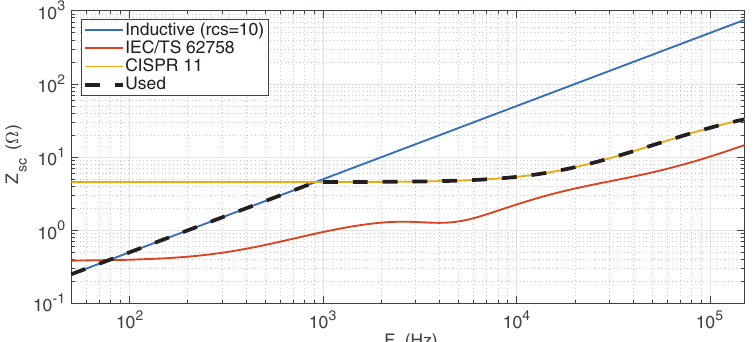
Figure 9. Comparison of grid models for frequency range up to